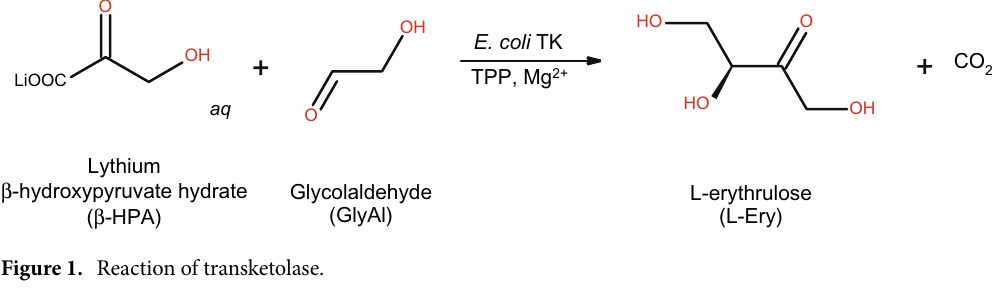
Figure 1. Reaction of